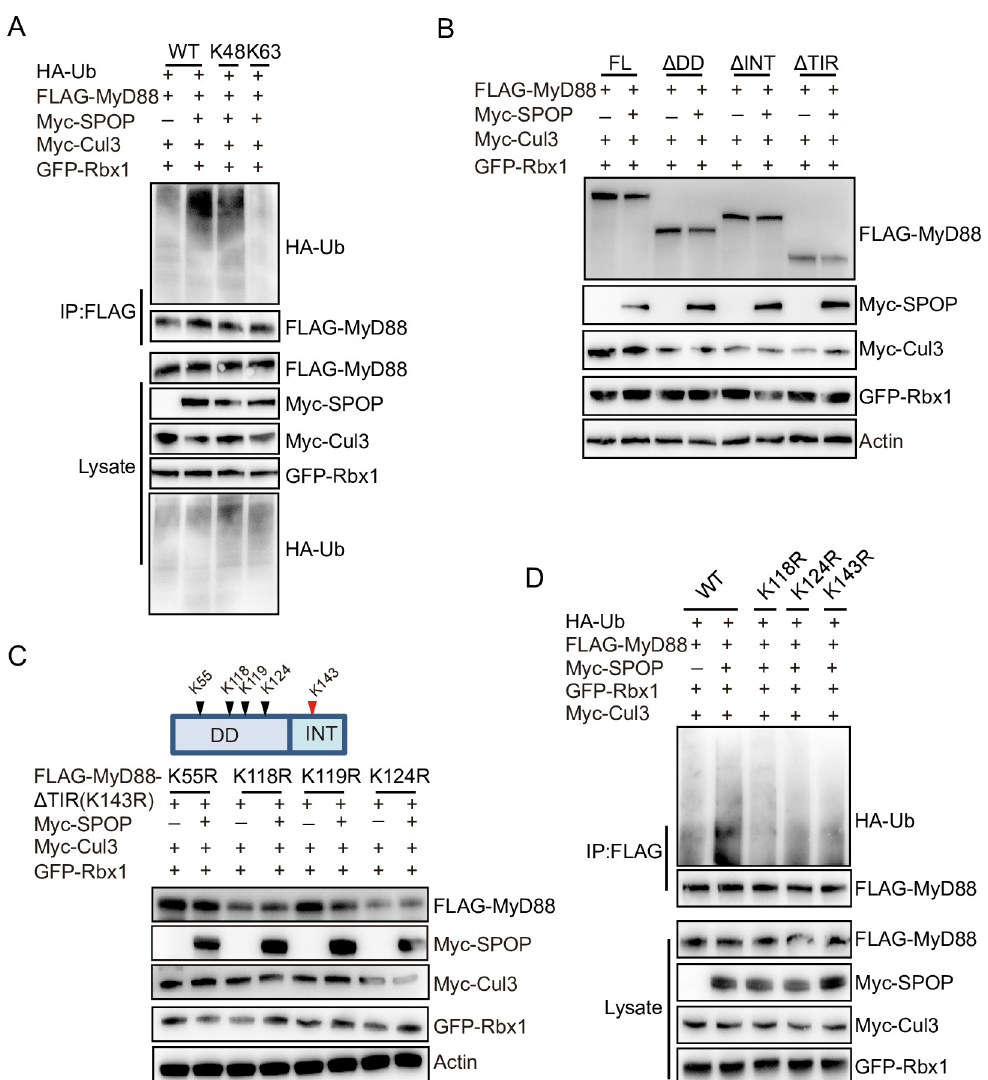
Fig 3. ChSPOP promotes K48-linked polyubiquitination of chMyD88. (A) Immunoblot analysis of immunoprecipitated chMyD88 from chicken DF1 cells transfected with indicated plasmids. Immunoprecipitation was carried out with anti- FLAG antibody and then probed with indicated antibodies. (B) Immunoblot analysis of lysates from chicken DF1 cells transfected with indicated plasmids. (C) K118 and K124 of chMyD88 are required for the downregulation of chMyD88 by chSPOP. Truncated chMyD88 K143R constructs consisting of the death-like and intermediate domain with additional K55R, K118R, K119R, or K124R point mutations were transfected into chicken DF1 cells. Expression of the K143R constructs of chMyD88 was detected by anti-FLAG antibody. (D) Mutations at K118, K124, and K143 reduce the polyubiquitination of chMyD88. Wild-type, K118R, K124R, or K143R chMyD88 was transfected into chicken DF1 cells alongside chSPOP. chMyD88 was immunoprecipitated by anti-FLAG antibody, and by immunoblotting performed with indicated antibodies.